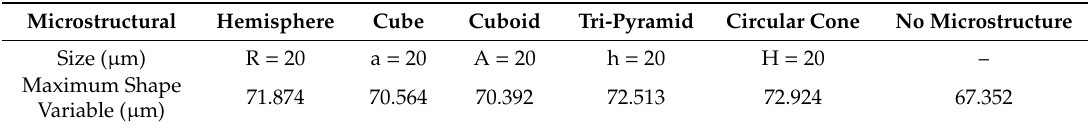
Table 1. Maximum shape variables of di ff erent